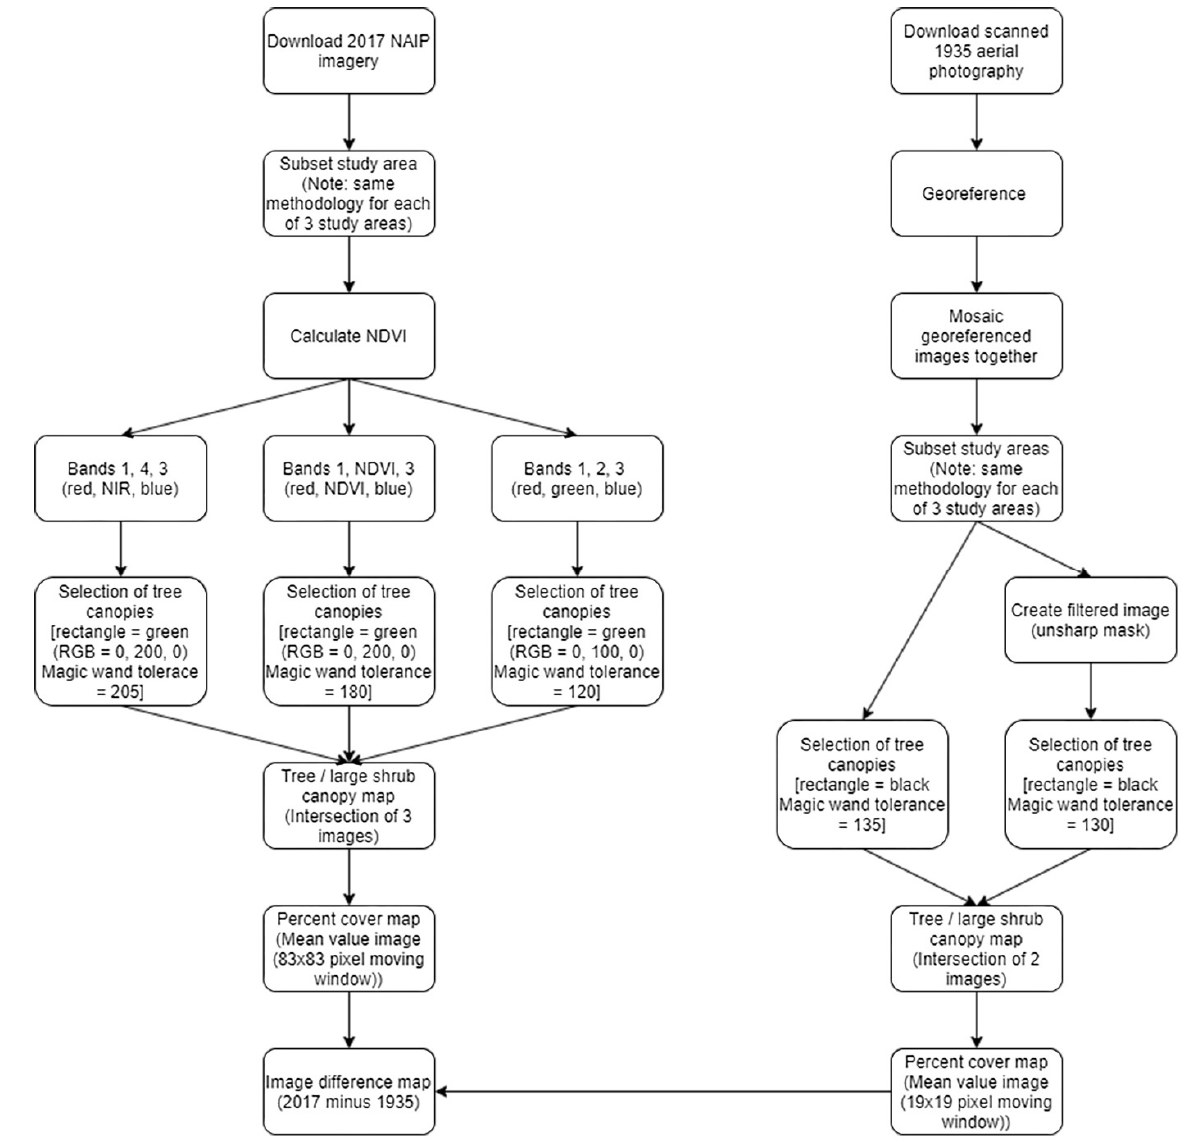
Figure 4. Methodology flowchart .